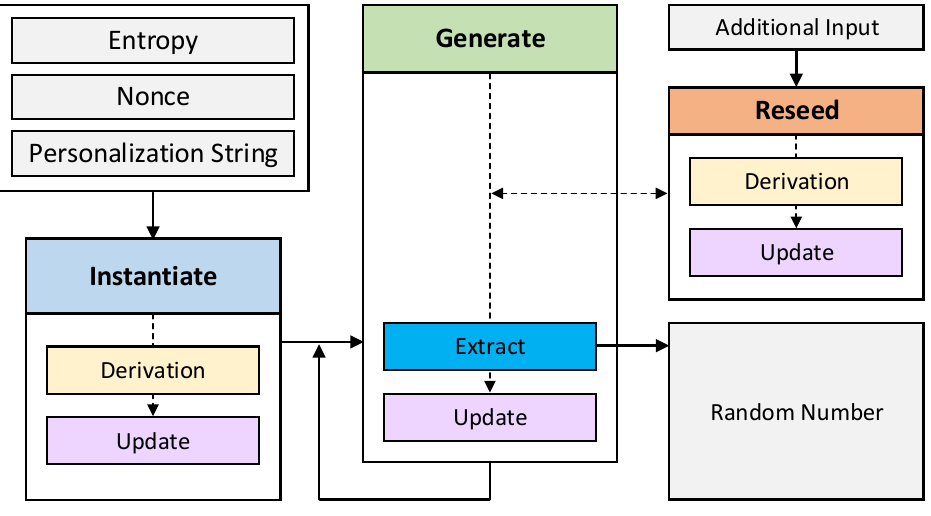
Figure 4. Counter Mode Based Deterministic Random Bit Generator (CTR_DRBG) overall process.